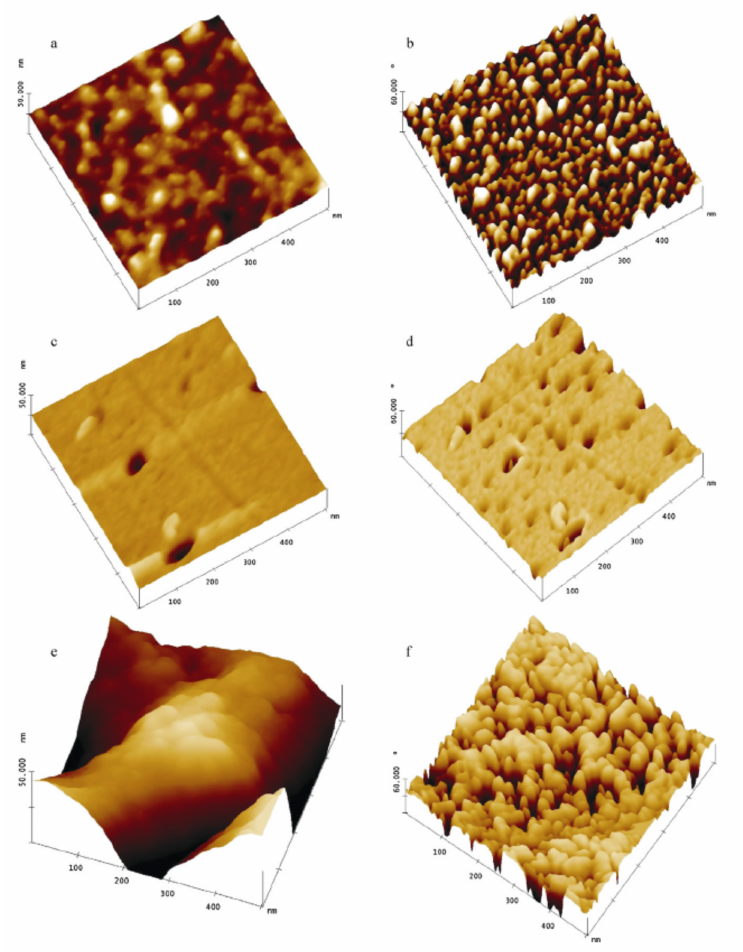
Figure 10. AFM images (500 nm × 500 nm) of the reference sample ( a ) morphology and ( b ) phase image; the same sample containing Zn 2+ ions, after adsorption from the Zn 2+ ion solution (initial concentration 80 mg/L) ( c ) morphology and ( d ) phase image; ( e ) the same sample containing Zn 2+ ions adsorbed (initial concentration 320 mg/L) and ( f ) the phase image. For surface morphology images z-range is 10 nm, while for phase images z-range it is 60 ◦ . Reprinted from [156]. Copyright (2011), with permission from